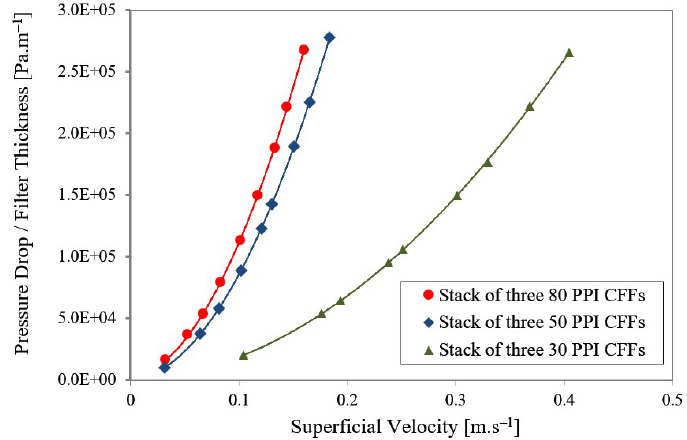
Figure 4. Empirically obtained pressure gradients of stack of three 80 PPI CFFs (the red, solid curve), stack of three 50 PPI CFFs (the blue, solid curve) and stack of three 30 PPI CFFs (the green, solid curve) as a function of superficial velocity.